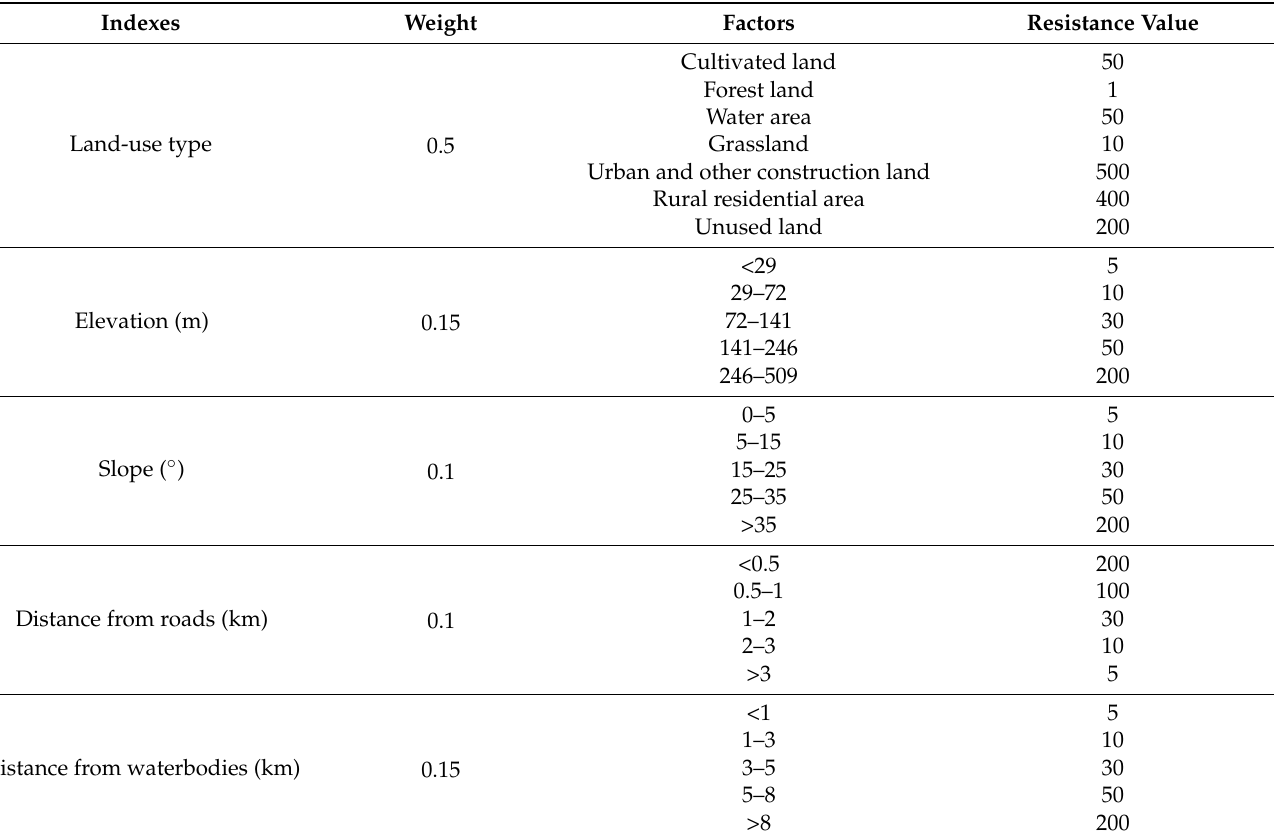
Table 3. Resistance-factor assignment